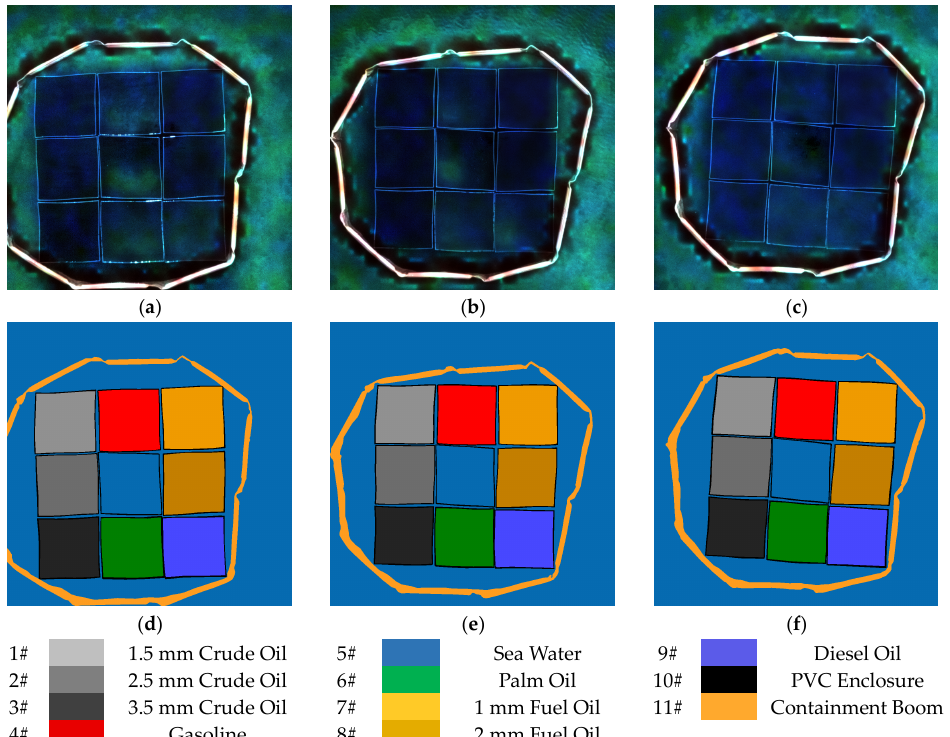
Figure 8. Oil spill hyperspectral images (red: 482 nm, green: 550 nm, blue: 662 nm) and sample label data of T1-T3. ( a , d ) are image and label data at T1, respectively. ( b , e ) are image and label data at T2, respectively. ( c , f ) are image and label data at T3, respectively.